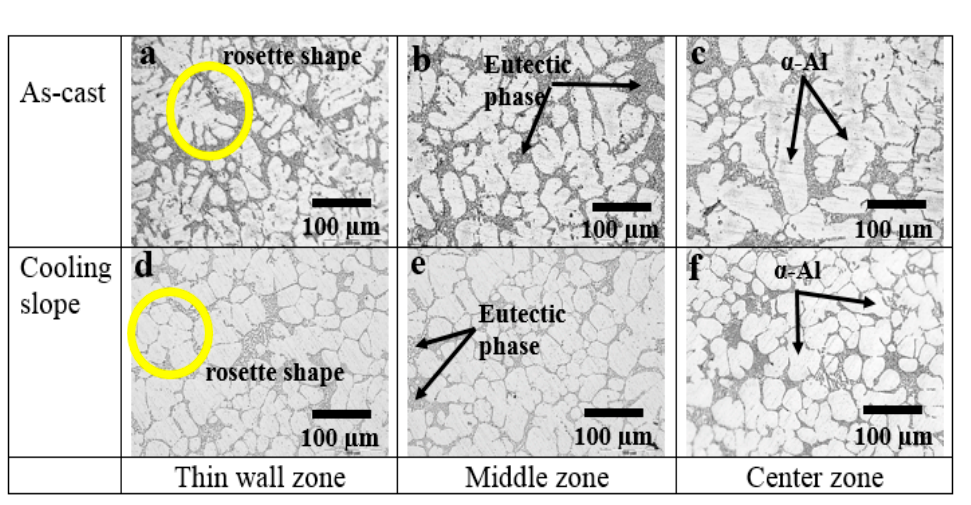
Figure 2. Microstructure of as-cast ( a – c ) and cooling slope casting samples ( d – f ). ( a ) coarse dendritic and rosette shape of α -Al phase at thin wall zone; ( b ) and ( c ) dendritic shape in the middle and center zone in as-cast samples; ( d ) rosette shape of α -Al phase at thin wall zone; ( e ) and ( f ) nearly globular shape at the middle and in the center zone of cooling slope